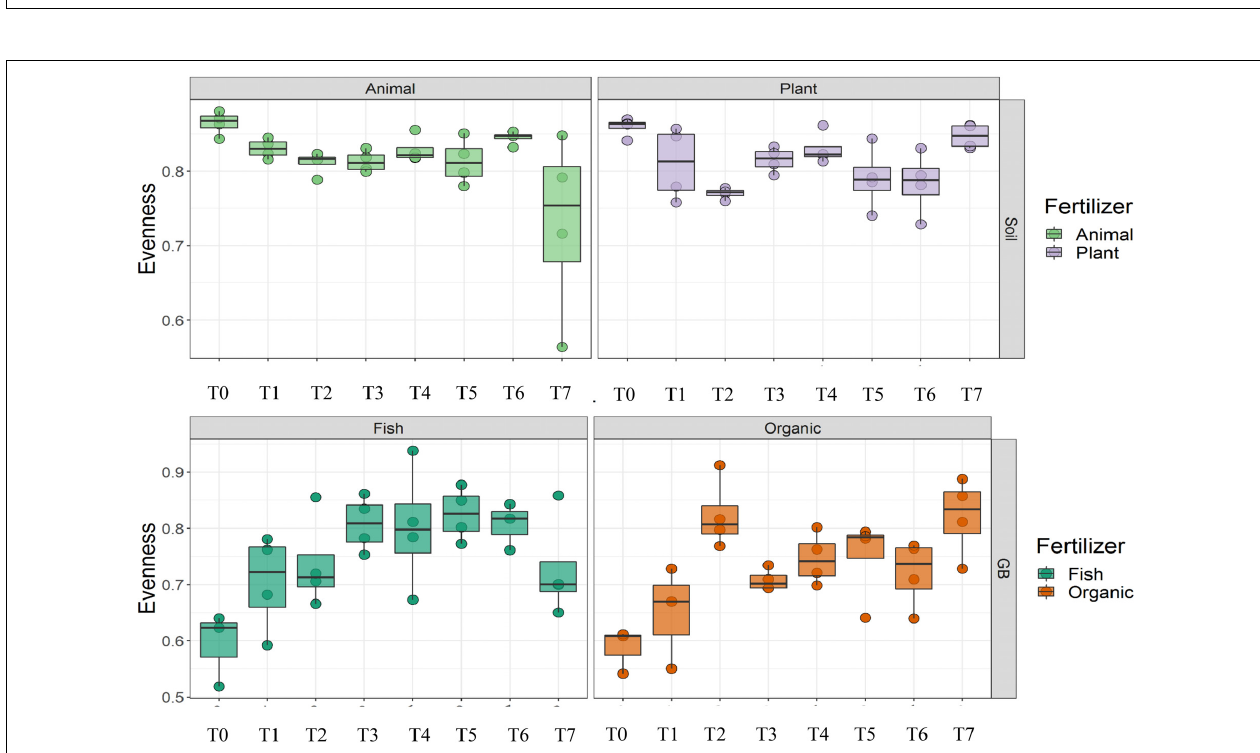
FIGURE 5 | Culture system impacted bacterial community characteristics and showed opposite trends. On the contrary, evenness was consistently higher in soil (upper panel) , while it tend to decrease in the aquaponics soilless system. (lower panel left) Samples for microbial community analysis were taken at 8 different timepoints, i.e., 55 DAS (T0), 68 DAS (T1), 83 DAS (T2), 113 DAS (T3), 146 DAS (T4), 172 DAS (T5), 221 DAS (T6), and 321 DAS (T7).